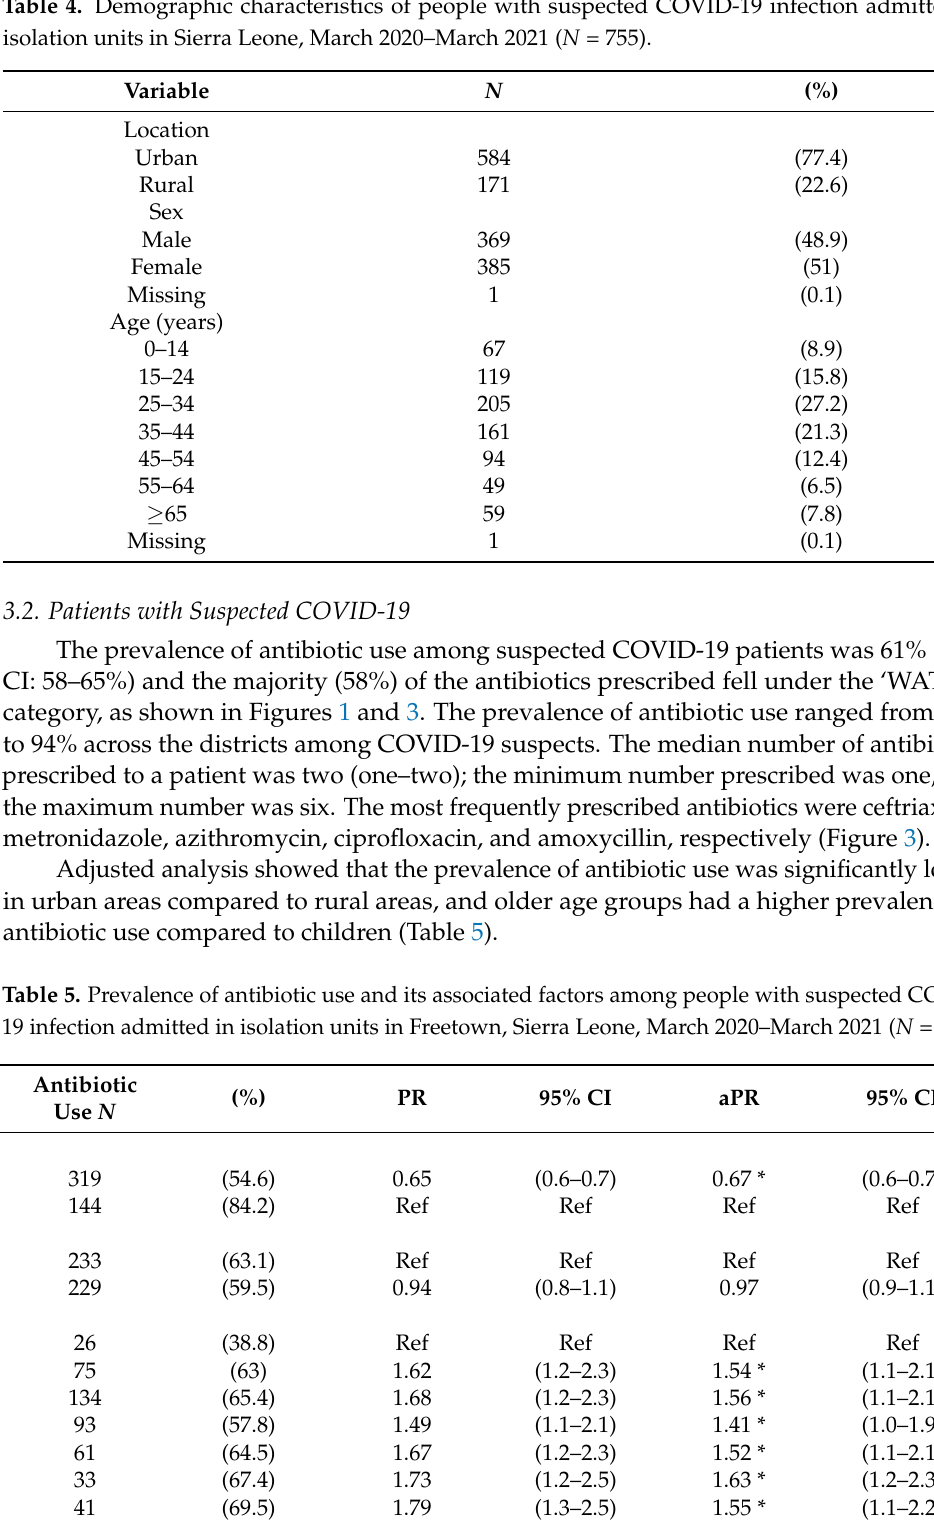
Table 4. Demographic characteristics of people with suspected COVID-19 infection admitted to